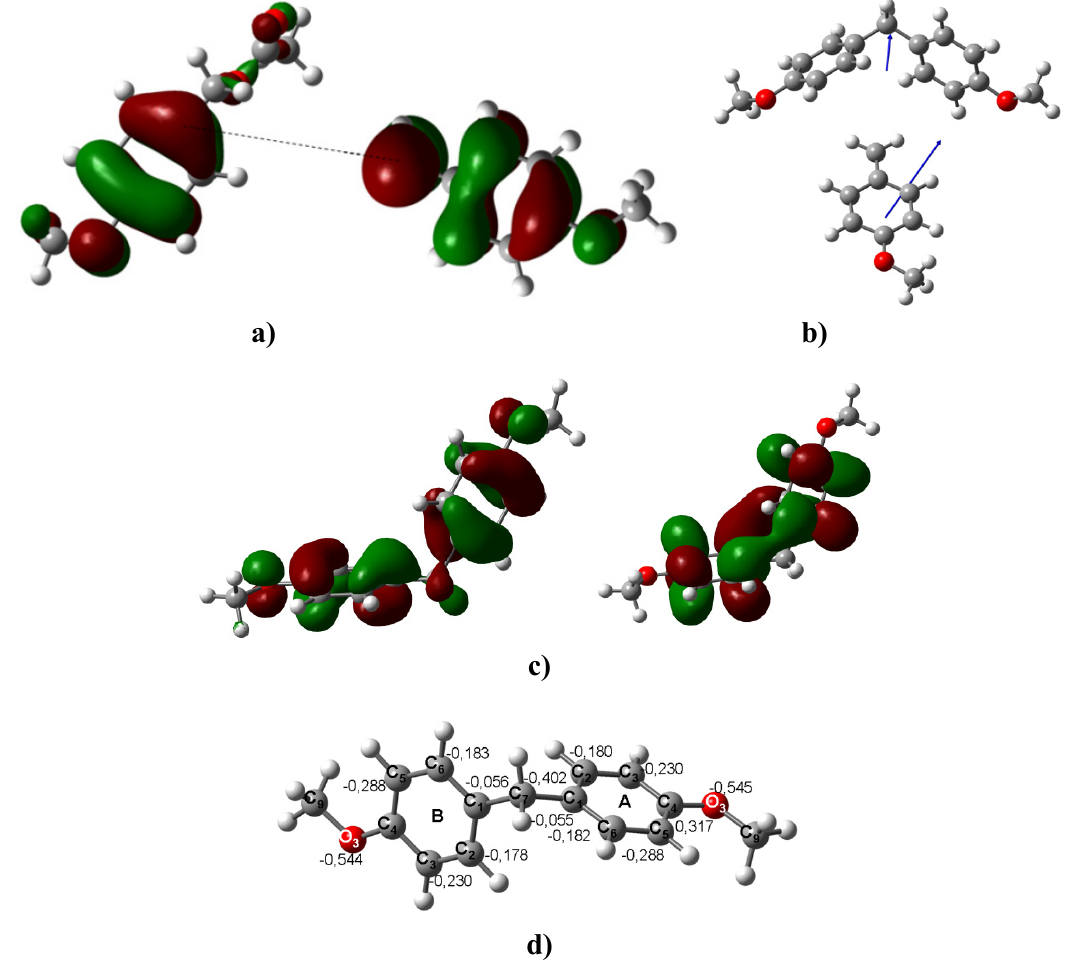
Figure 6. a) The HOMO of para -methoxybenzyl acetate and the LUMO of the methoxybenzyl carbenium ion that yield oligomer 4 . b) The DM of the carbenium ion must be aligned towards the methylene group of 4 . This centered orientation prevents any further substitution under the reported experimental conditions. c) The HOMO and LUMO of 4 . d) The optimized B3LYP/6-311++G(d,p) geometries for 2 . The calculated NPA charges are reported in e -